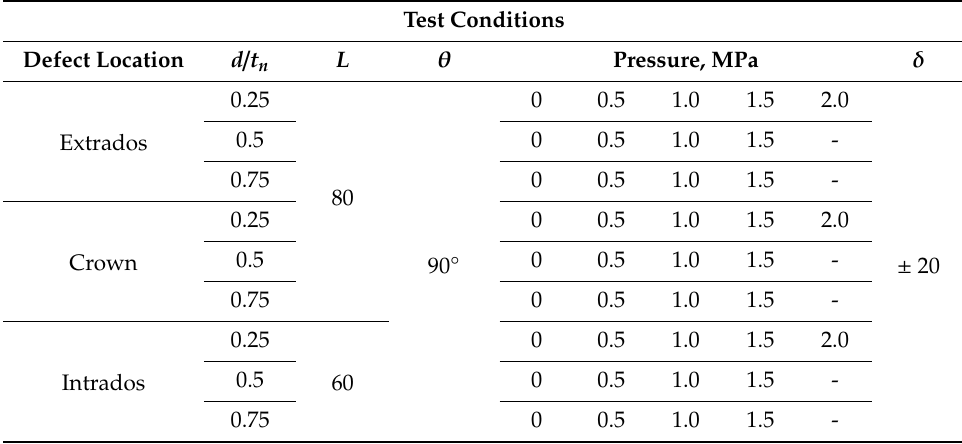
Table 2. Summary of test conditions for short and long bend elbows.